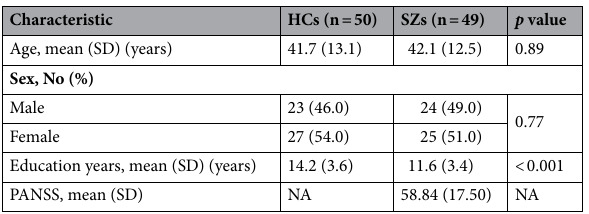
Table 1. Demographic and clinical characteristics used in the analysis. HCs healthy controls, SZs patients with schizophrenia, NA not